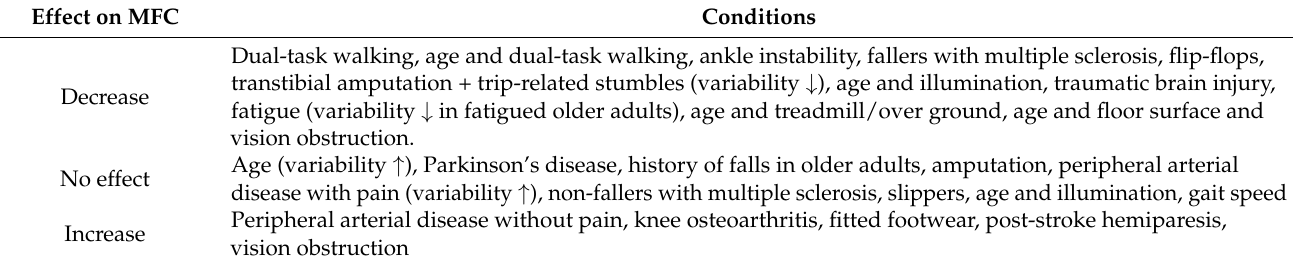
Figure 8. Forest plots of conditions comprising one study with a decrease in MFC mean effect relative to control (* = original manuscript reports different finding, YA = younger adults, OA = older adults). Table 6. All conditions compiled based on effect on